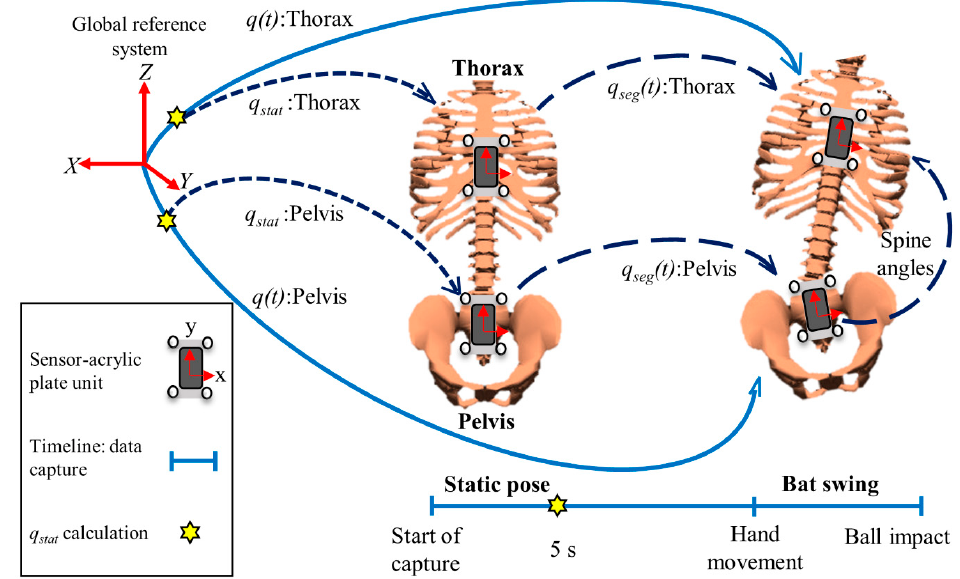
Figure 1. Orientation definition in quaternion for both static position and hitting a baseball off a tee-